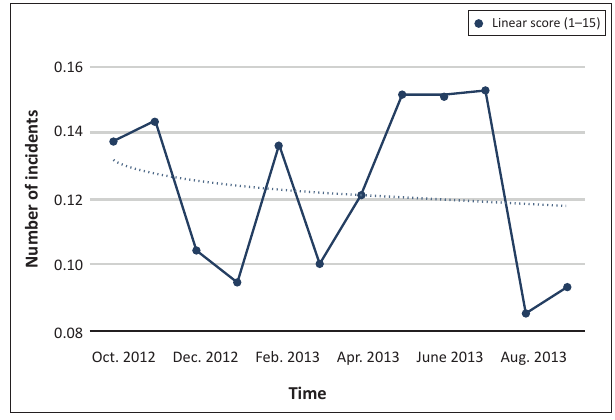
FIGURE 3: Critical incident triangles for Fleets 1–3 in this study.